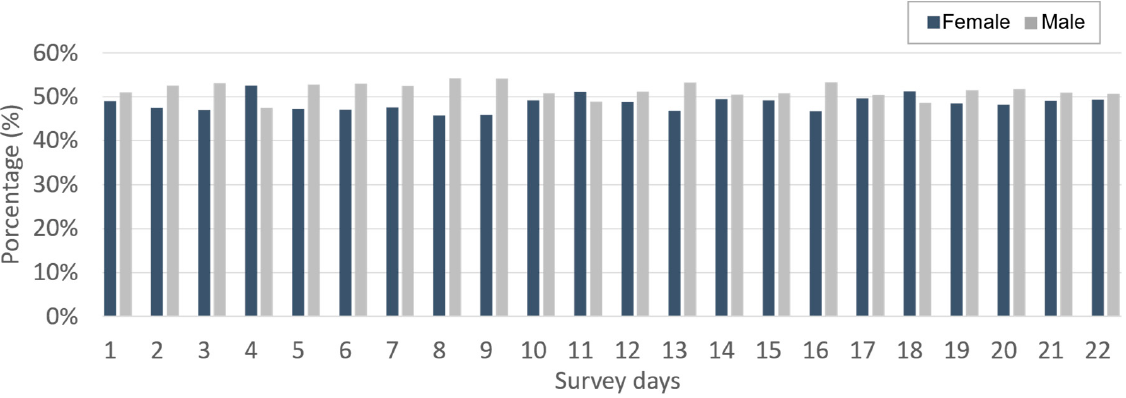
Figure 14. The gender percentage of people surveyed.